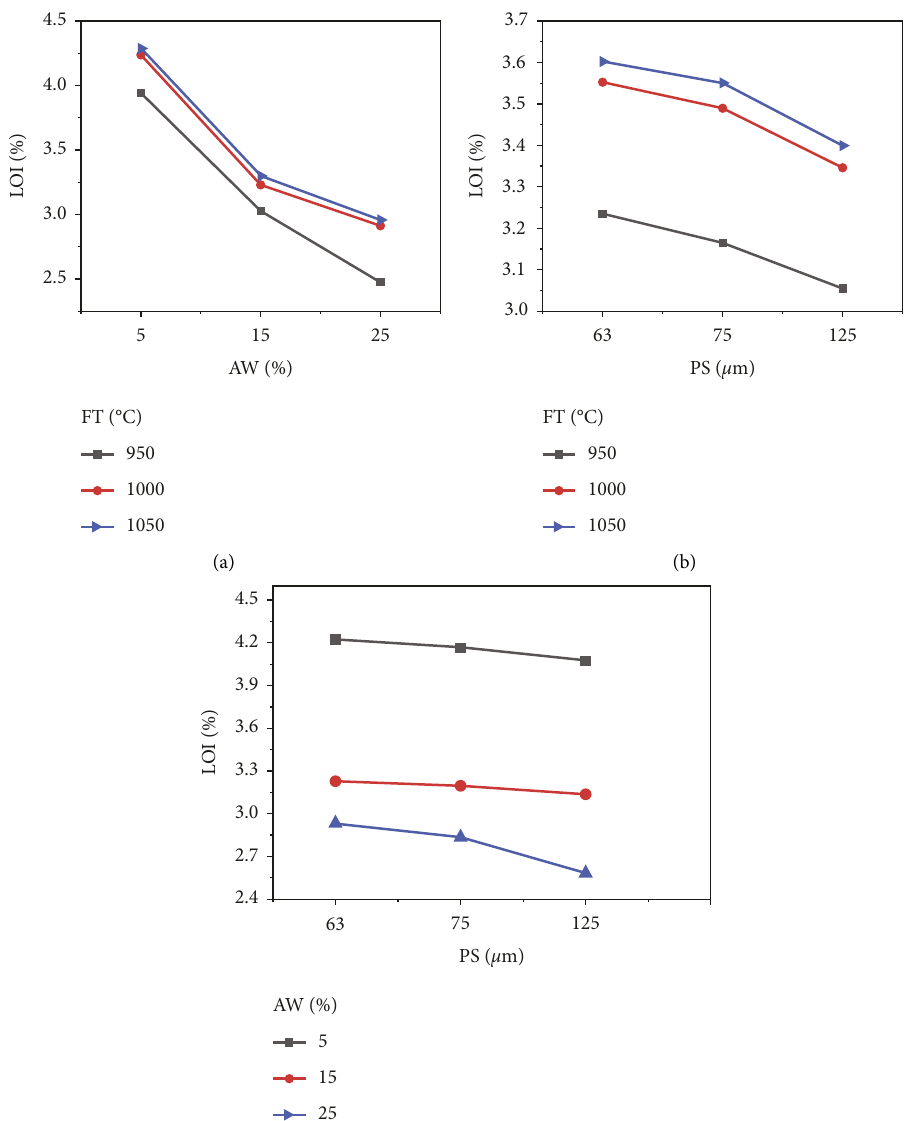
Figure 5: Effect of FT and AW (a), PS and FT (b), and PS and AW (c) on